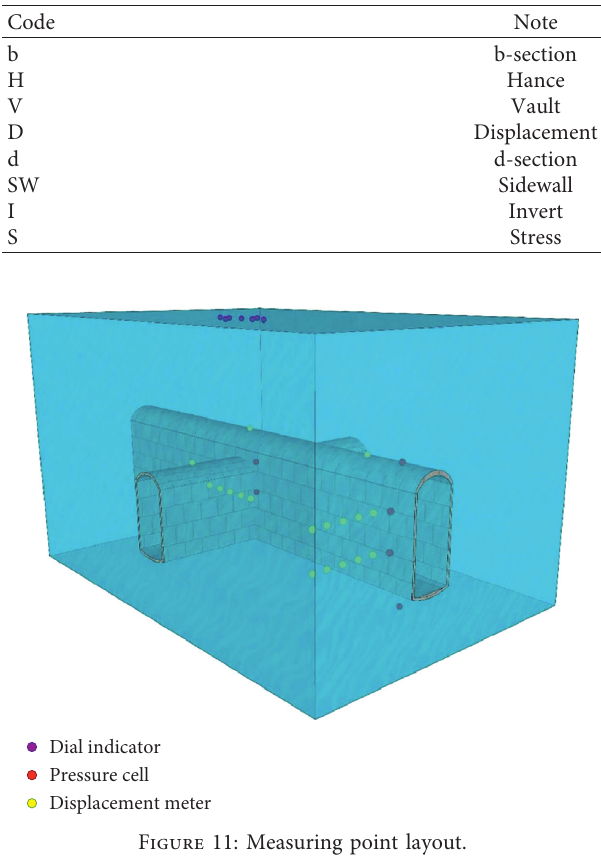
Figure 11: Measuring point